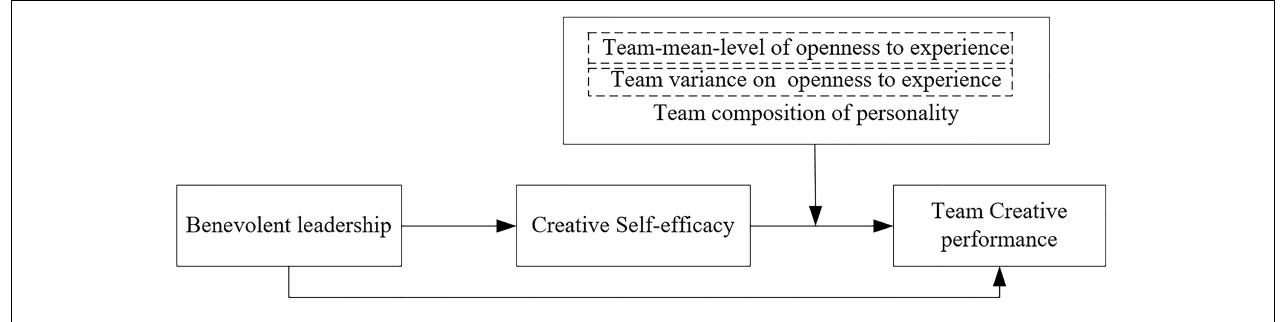
FIGURE 1 | Hypothesized